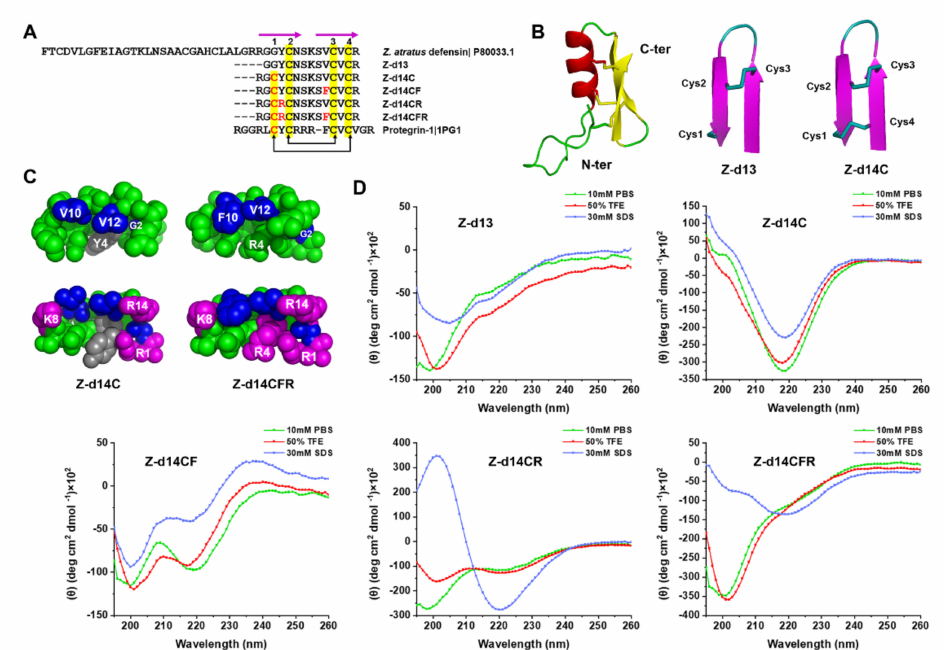
Figure 2. Design and structural analysis of Z. atratus defensin analogues. ( A ) Sequence alignment between Z. atratus defensin analogues and Protegrin-1 (PG-1, PDB ID: 1PG1). Rose lines represent the β -sheet region of peptides. The conserved cysteines are shadowed in yellow, the mutated residues are colored in red, the black arrows indicate the disulfide bonds of peptides. ( B ) Structural model (ribbon diagram) of Z. atratus defensin, Z-d13 and Z-d14C in accordance with ( A ). The structure of Z. atratus defensin was predicted according to Sapecin (PDB ID: 1L4V) by SWISS- MODEL (http://swissmodel.expasy.org/) (Accessed: 20 March 2022). Z. atratus defensin consists of N -terminal random coil followed by a α -helical and antiparallel β -sheet. Z-d14C forms a new disulfide bond between Cys1–Cys4 after mutating Gly into Cys at the 3rd position. ( C ) Clustering of hydrophilic residues (green), hydrophobic residues (blue) and positive residues (rose red) in Z-d14C and Z-d14CFR. ( D ) Circular dichroism (CD) spectra of Z. atratus defensin analogues in 10 mM PBS (green line), 50% trifluoroethanol (TFE) (red line) and 30 mM SDS (blue